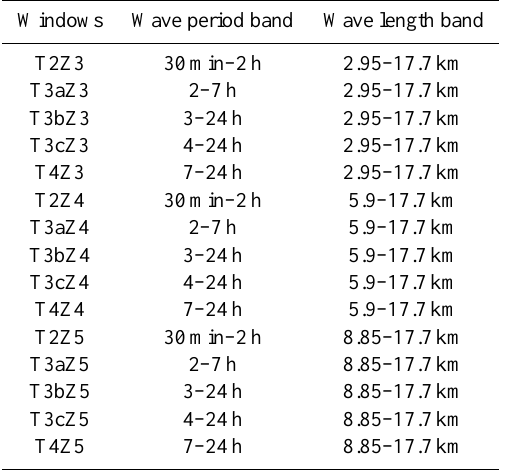
Table 1. Wave period bands and wave length bands corresponding to the frequency- and wave number- windows used to sample the wave packets for phase and group velocity tracing analysis.